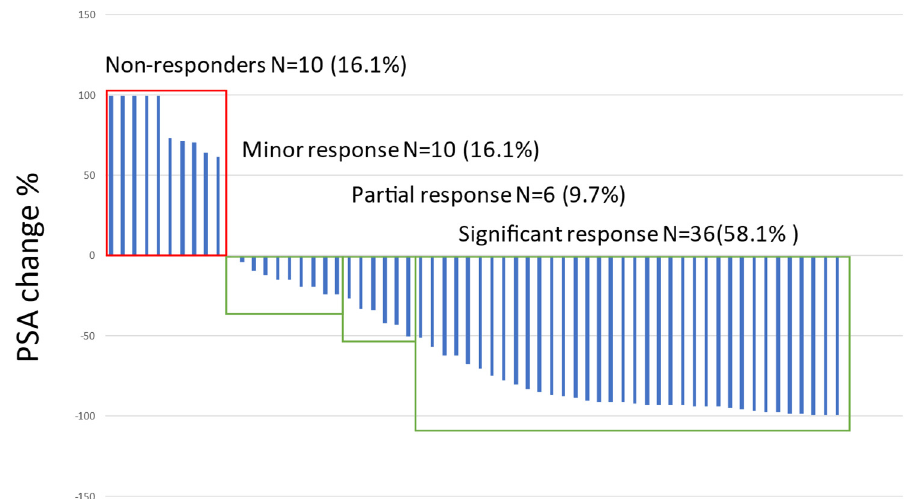
Figure 1. Waterfall plot on the best PSA response to 177 Lu-PSMA-treatments.